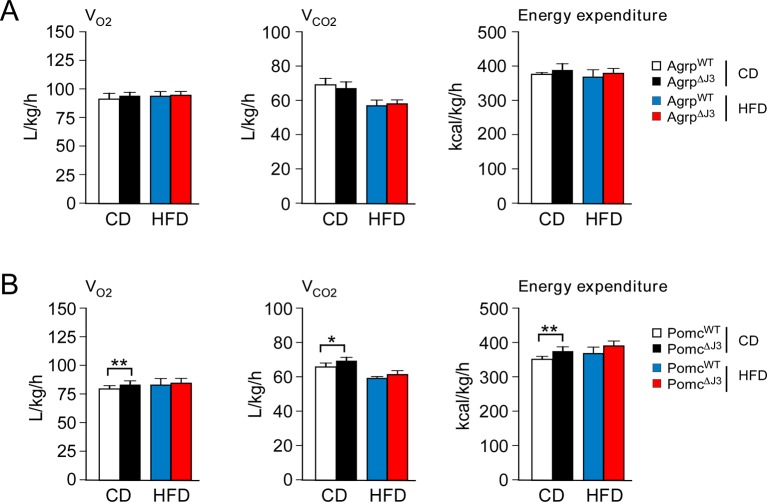
Effect of JNK3 deficiency in AgRP and POMC neurons on energy expenditure.(A) CD-fed and HFD-fed (4 wk) AgrpWT and Agrp∆J3 mice mice were examined using metabolic cages to measure VO2, VCO2, and energy expenditure (mean ± SEM; n=8; p>0.05). (B) CD-fed and HFD-fed (4 wk) PomcWT and Pomc∆J3 mice were examined using metabolic cages to measure VO2, VCO2, and energy expenditure (mean ± SEM; n=8; *p<0.05; **p<0.01).